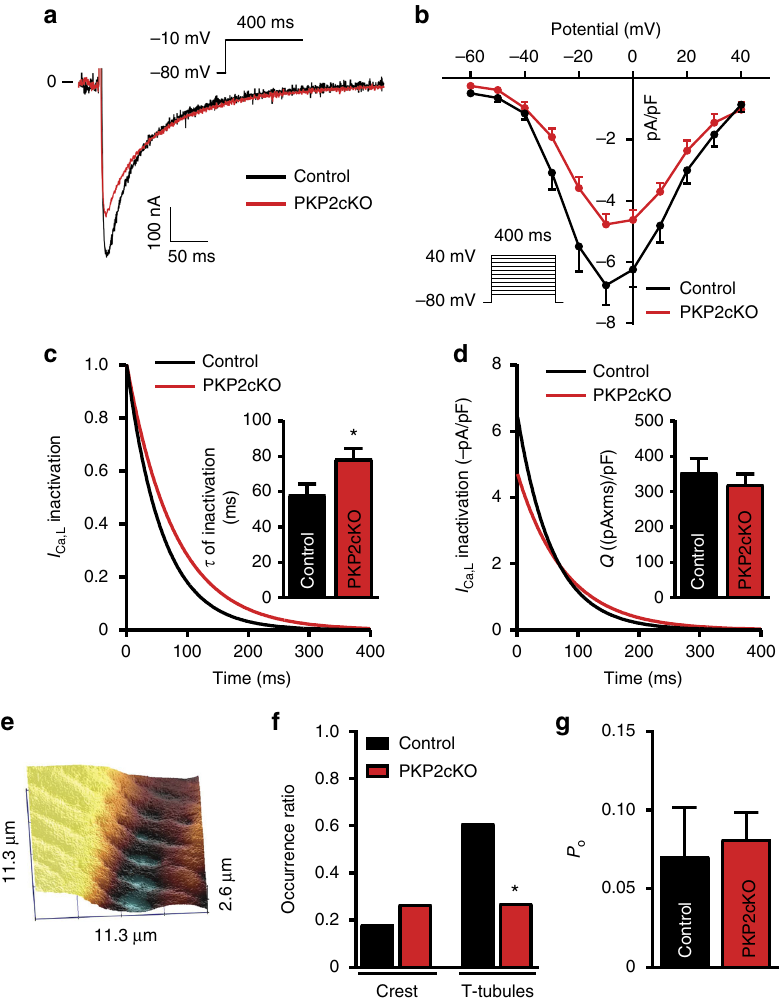
Fig. 6 Calcium current in PKP2-cKO cardiomyocytes at 21 dpi. a L-type calcium current in control ( black ) and PKP2-cKO ( red ). b Peak L-type calcium current density as a function of voltage recorded in control ( black ) and PKP2-cKO ( red ) cardiomyocytes. Voltage clamp protocol in inset. c Normalized L-type calcium current decay in control ( black ) and PKP2-cKO ( red ) cardiomyocytes. Inset: Tau of inactivation of the L-type calcium current in control ( black ) and PKP2-cKO ( red ) cardiomyocytes. Student ’ s t -test, * p < 0.05 vs. control. d L-type calcium current decay in control ( black ) and PKP2-cKO ( red ) cardiomyocytes. Inset: Charge ( Q ) passing through calcium channels during L-type calcium current in control ( black ) and PKP2cKO ( red ) cardiomyocytes. For b , c and d , results collected from 13 cells, three mice in the control group and 10 cells, three mice in the PKP2-cKO group. e Example of SICM recording showing crest and T-tubules. f Occurrence ratio of calcium channels at crest and T-tubules measured by SICM in control ( n = 11 and 18 for crest and T-tubules respectively; black ) and PKP2-cKO ( n = 15 and 22 for crest and T-tubules respectively; red ) cardiomyocytes. Five mice in each group. χ 2 test, * p < 0.05 vs. control. g Calcium channel unitary conductance in control ( n = 5; black ) and PKP2-cKO ( n = 5; red ) cardiomyocytes. Five mice in each